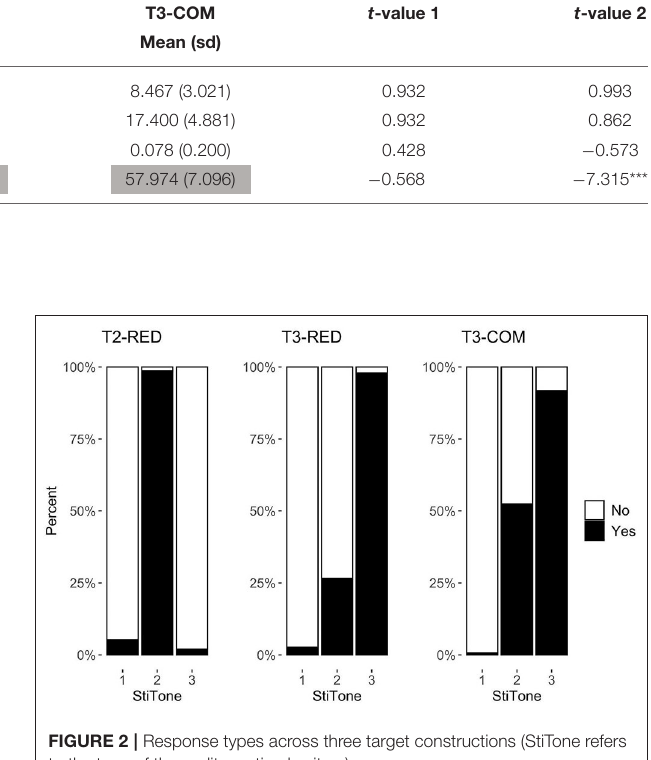
model based on Likelihood ratio test significance. A